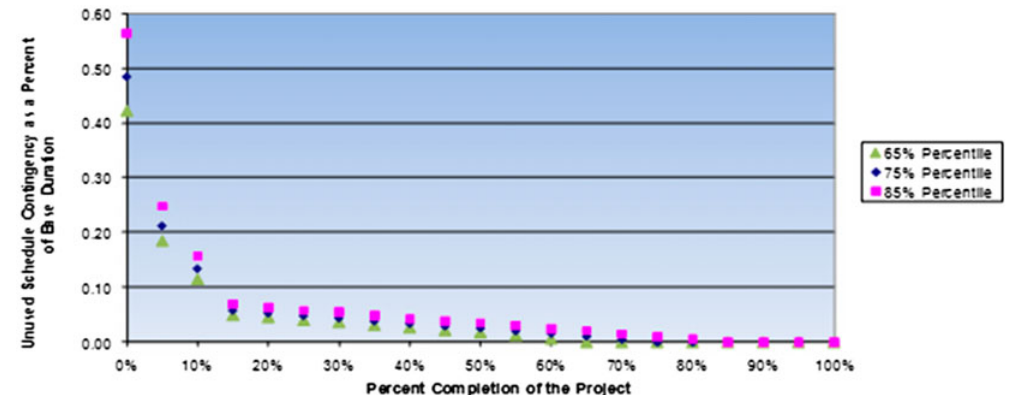
Fig. 3. Unused schedule contingency as a percent of base duration vs. project percent